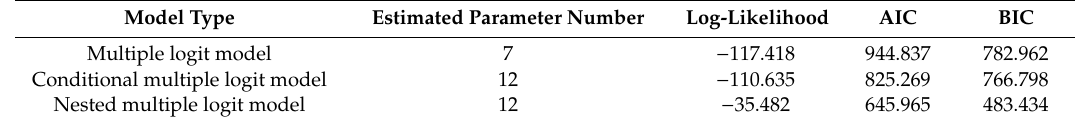
Table 3. Comparison of the goodness of fit among the three models.